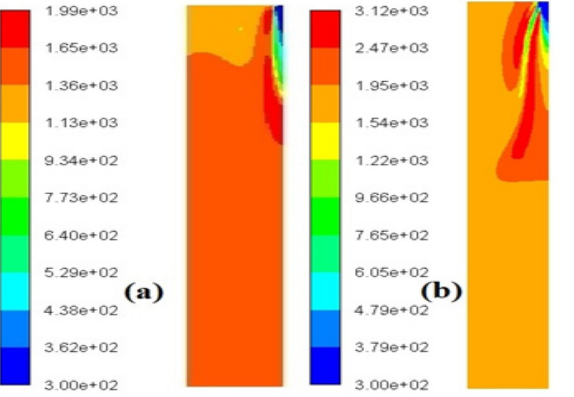
Figure 27. Contours of gas temperature (in K) where the right vertical line represents the axis of symmetry: ( a ) Reactor 1 and ( b ) Reactor 2.